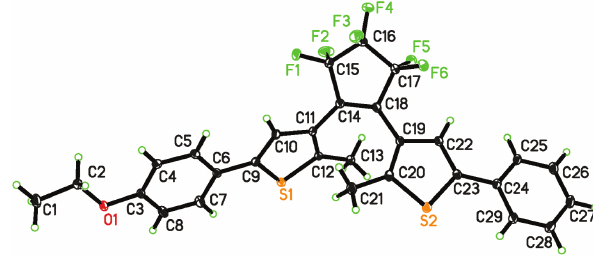
Figure: Molecular view of the title compound. Ellipsoids are drawn at 30% probability level.